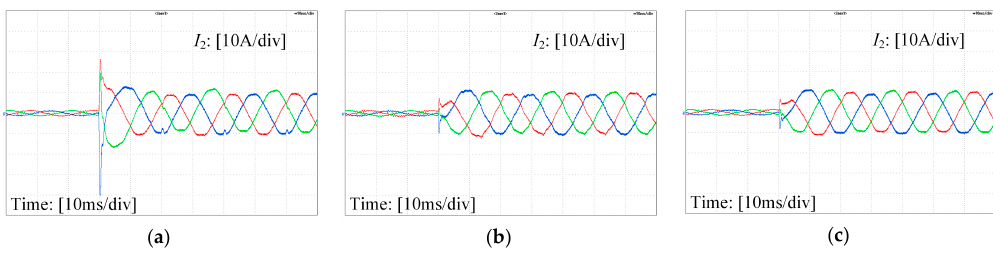
Figure 11. Grid-connected converter starting in rectifier mode. ( a ) NFF; ( b ) SCVDFF; ( c ) DFPS-CVFF. When grid inductance L ’g = 0, experimental results of the grid-connected converter starting in